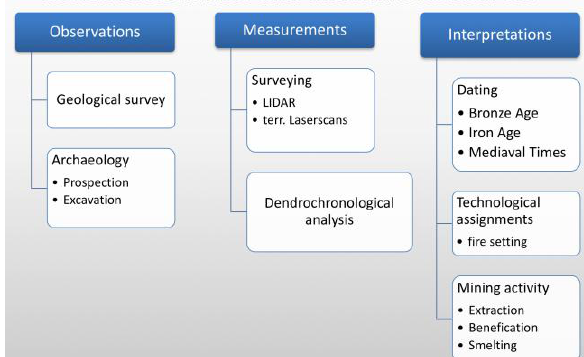
Figure 8. Refinement of Research Activities and Information Sources in a